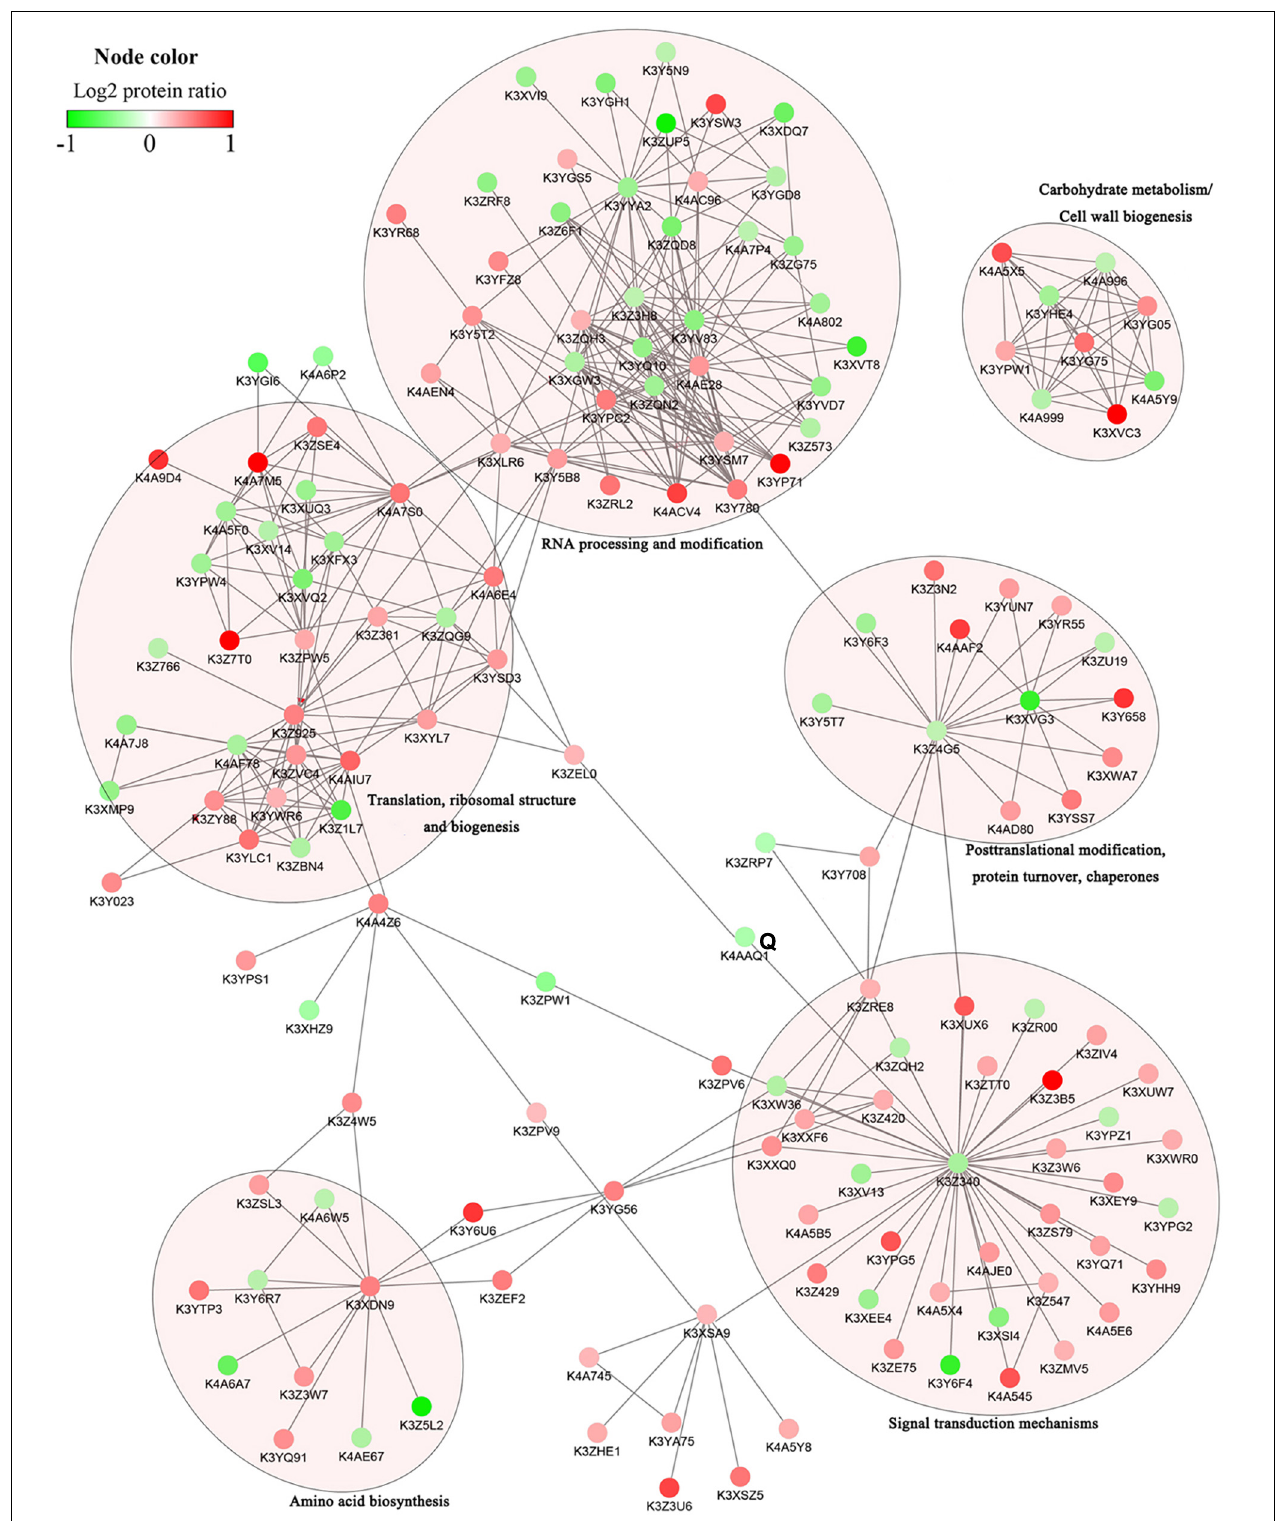
FIGURE 6 | Protein–protein interaction networks of DRPPs in six functional categories of Yugu2.